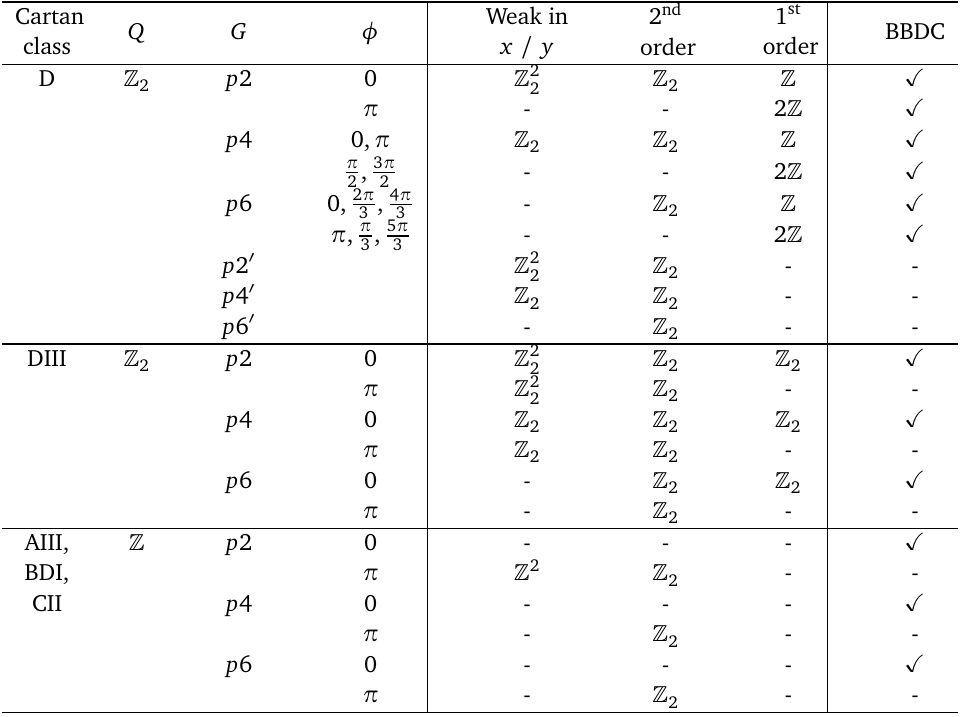
Table 1: Classification of two-dimenional n -fold rotation-symmetric weak, second- order, and first-order topological superconductors that give rise to anomalous bound- ary states. Q indicates the topological charge of zero-dimensional anomalous states in the given Cartan class. G denotes the space group pn ( pn (cid:48) ) with n -fold unitary (magnetic) rotation symmetry. φ is the U ( 1 ) phase determining the superconduct- ing pairing symmetry. The three central columns show the structure of the topo- logical invariants. For systems with first-order invariant 2 (cid:90) , the rotation symmetry constrains the Chern number to be even. The last column indicates whether the bulk- boundary-defect correspondence (BBDC) holds at a disclination ( (cid:216) ). The remaining (non-superconducting) Cartan classes do not allow for zero-dimensional anomalous states, i.e., they have Q =